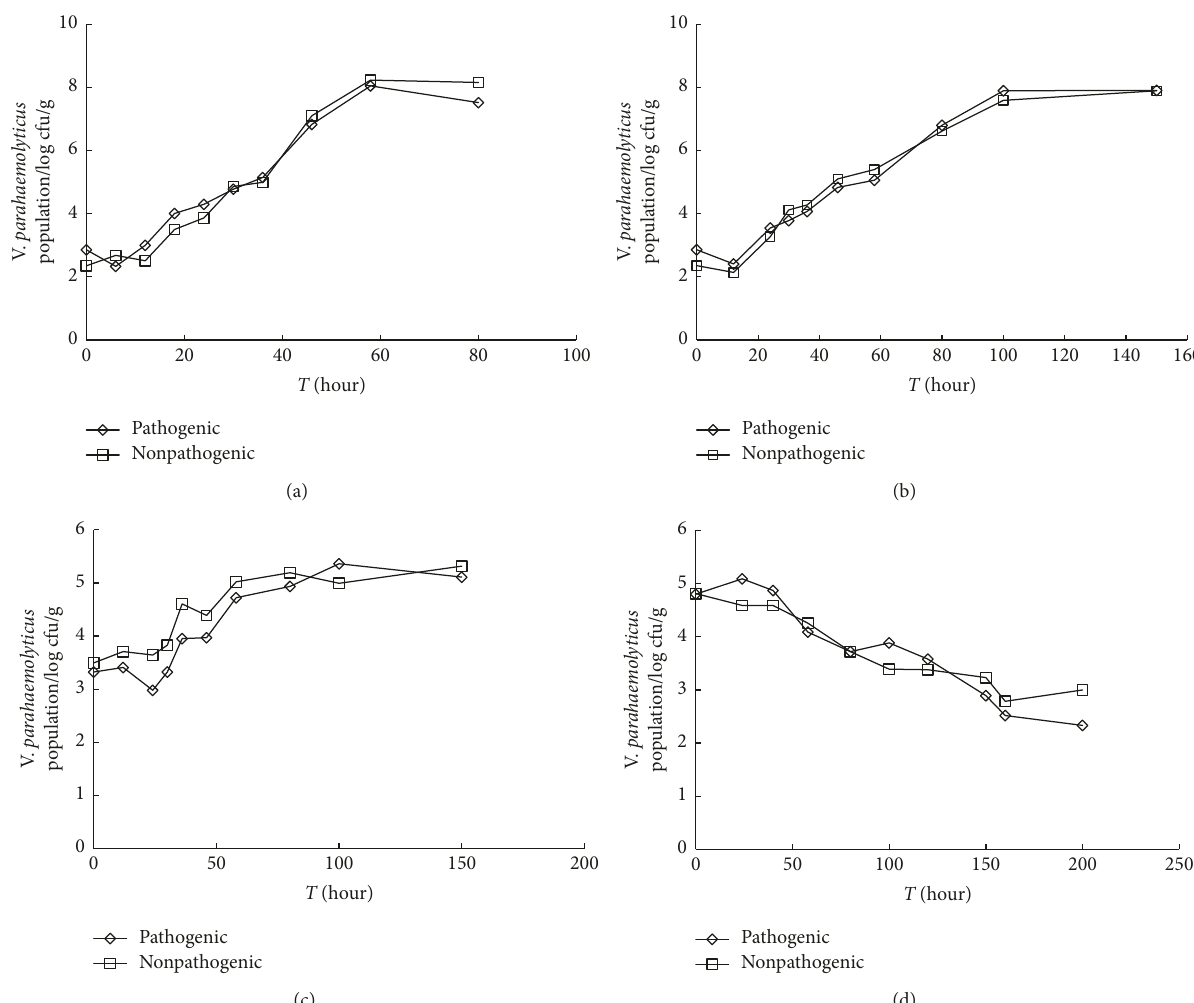
Figure 2: The observed growth of multiple strains of pathogenic and multiple strains of nonpathogenic V. parahaemolyticus in live JO stored at (a) 35 ∘ C, (b) 25 ∘ C, (c) 15 ∘ C, or (d) 5 ∘ C obtained through DLAP method.